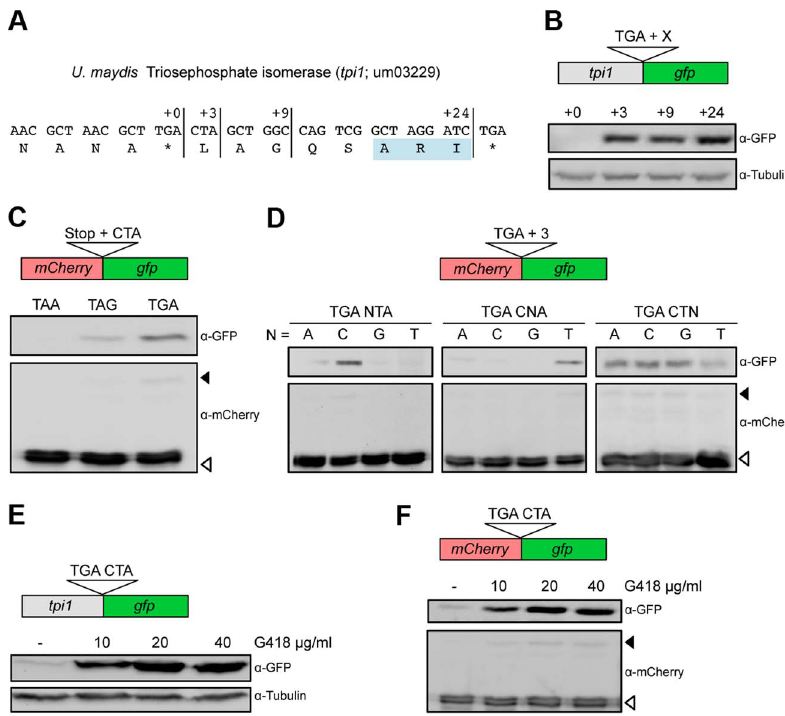
Figure 1. Characterization of sequence requirements for translational readthrough in U.maydis . (A) 3 9 sequence of the U. maydis tpi1 gene and its translation. PTS1 is highlighted. (B) Tpi1 with indicated C-terminal extensions was fused to GFP and analyzed by Western blot. (C) A reporter construct consisting of mCherry and gfp interrupted by a stop codon was expressed. Stop codon readthrough was analyzed by detection of GFP by Western blot. The termination codon TGA was replaced by TAA or TAG and tested in combination with the downstream sequence CTA for ribosomal readthrough. (D) Nucleotides downstream of TGA were exchanged as indicated and tested as described in (C) for stop codon readthrough. (E) Tpi1 including TGA CTA was fused to GFP. Cells were incubated with different amounts of G418 and analyzed for readthrough by Western blotting. (F) TGA CTA was inserted between mCherry and gfp of the reporter construct. Cells were incubated with different amounts of G418 and analyzed for readthrough by Western blotting. Filled arrows indicate readthrough products while blank arrows indicate products terminated at the first stop codon.